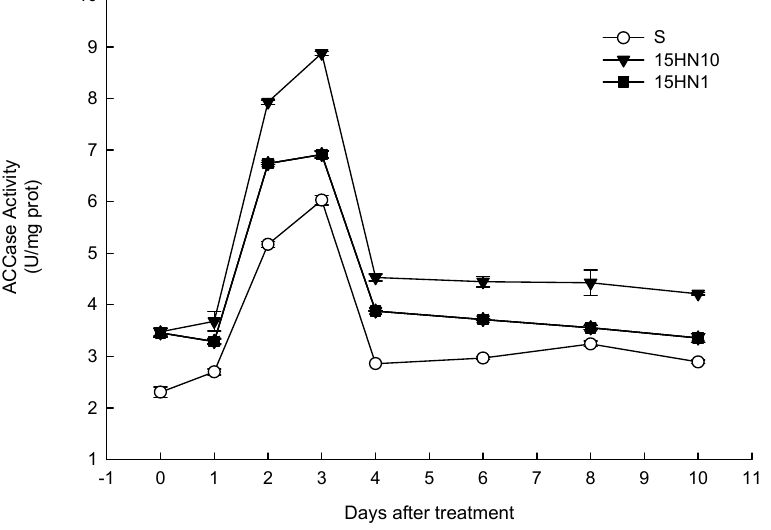
Figure 1. Activities of acetyl-CoA carboxylase in resistant (15HN10, 15HN1) and susceptible (S) Digitaria sanguinalis populations.